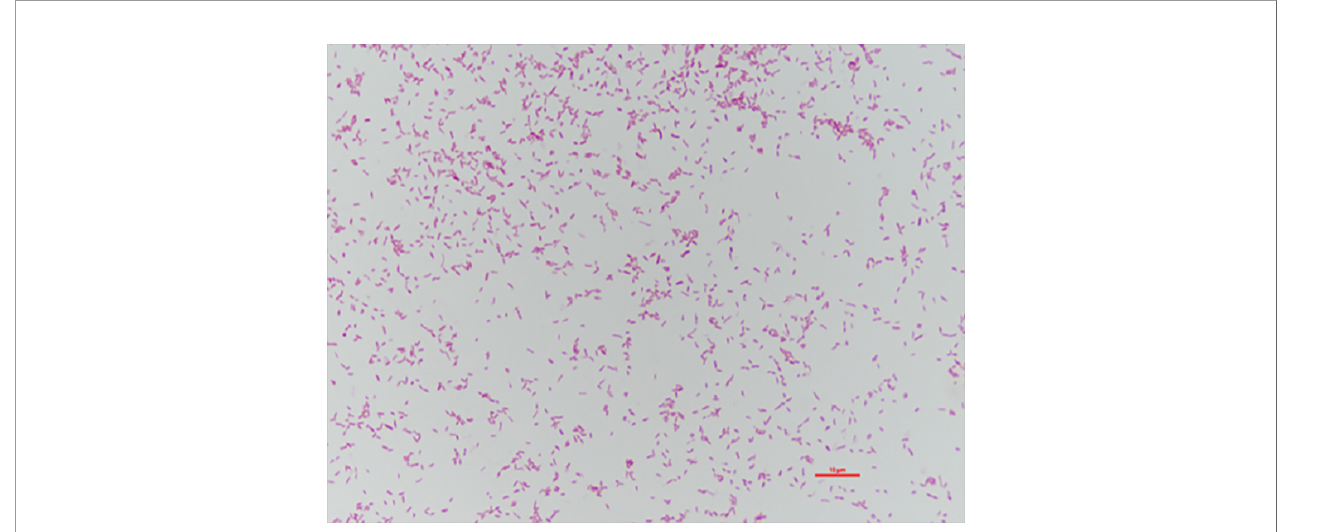
FIGURE 2 | Gram-staining of H. huttiense showed Gram-negative bacilli.